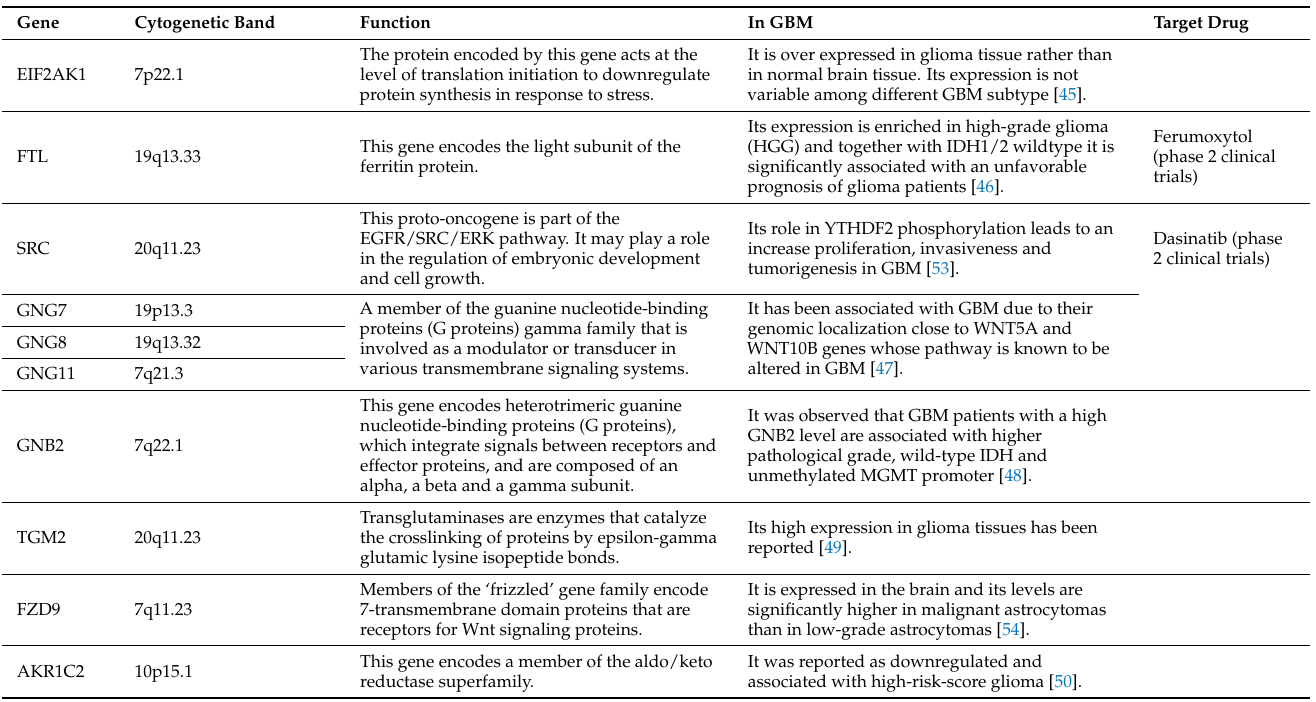
Table 8. Summary of relevant genes shared at least between two datasets of the enrichment analysis with DAVID. The following is reported: the cytogenetic localization, the function (GeneCards: The Human Gene Database, https: //www.genecards.org/, accessed on 20 September 2021) [51], the association with GBM and possible new targeted therapy (DrugBank database; https://go.drugbank.com/, accessed on 20 September 2021)